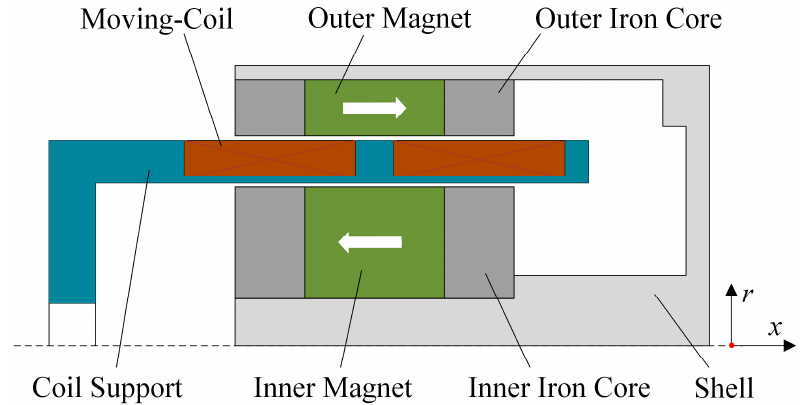
Figure 3. Sketch of the designed linear motor.